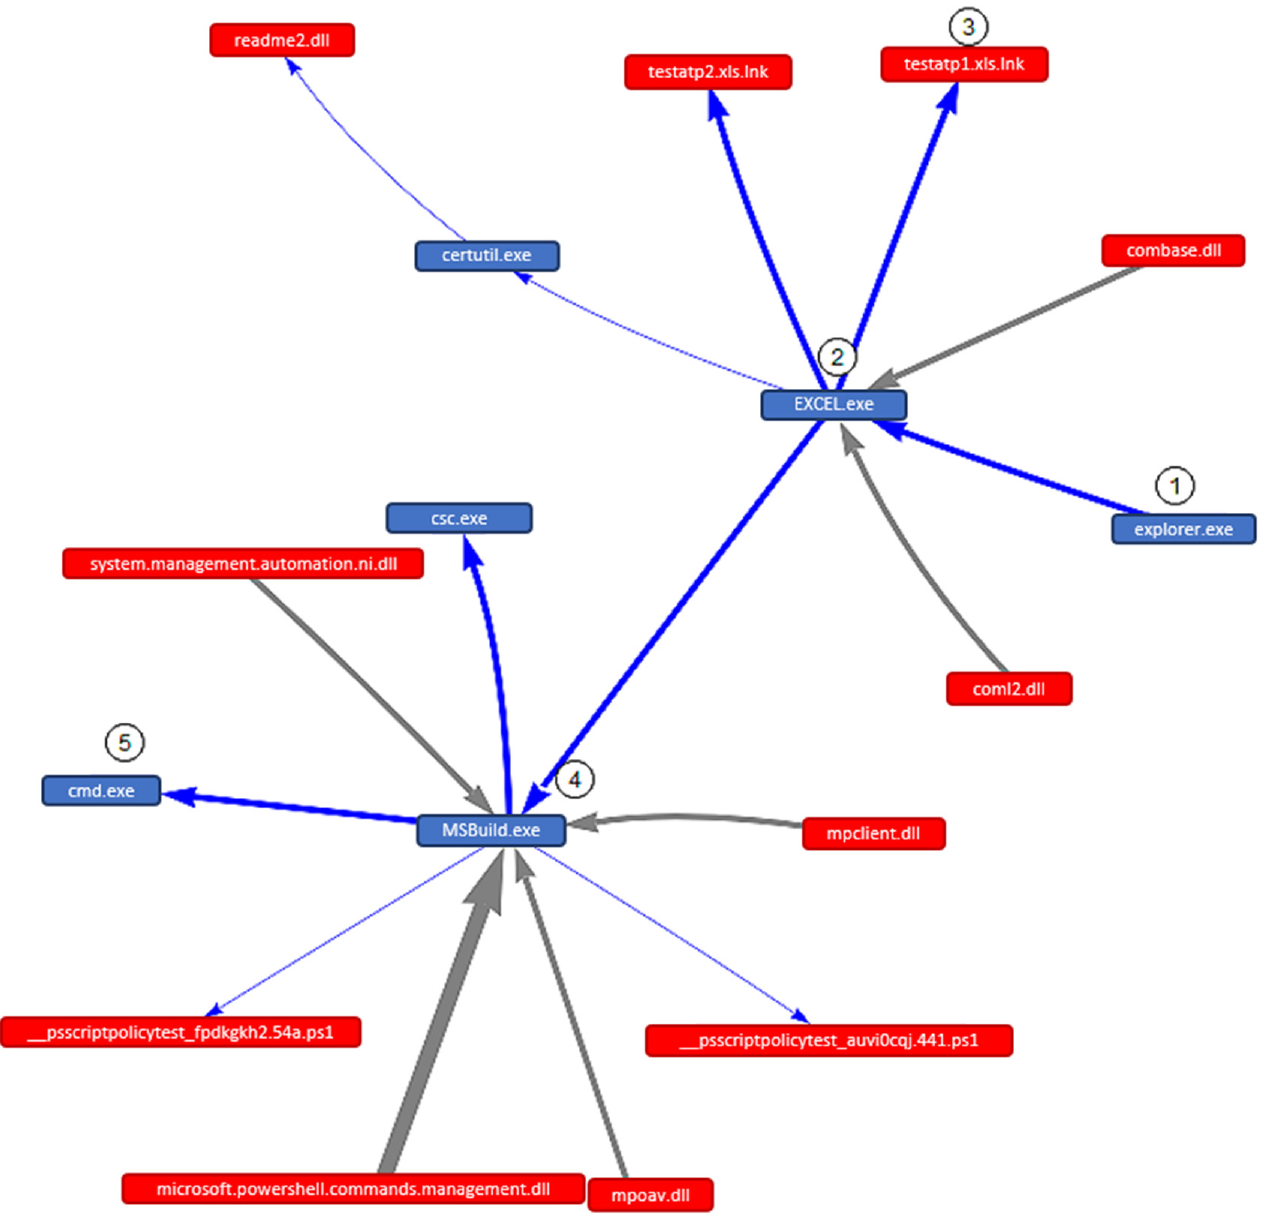
Figure 4. Result of the execution of an Excel document with MSBuild.exe.